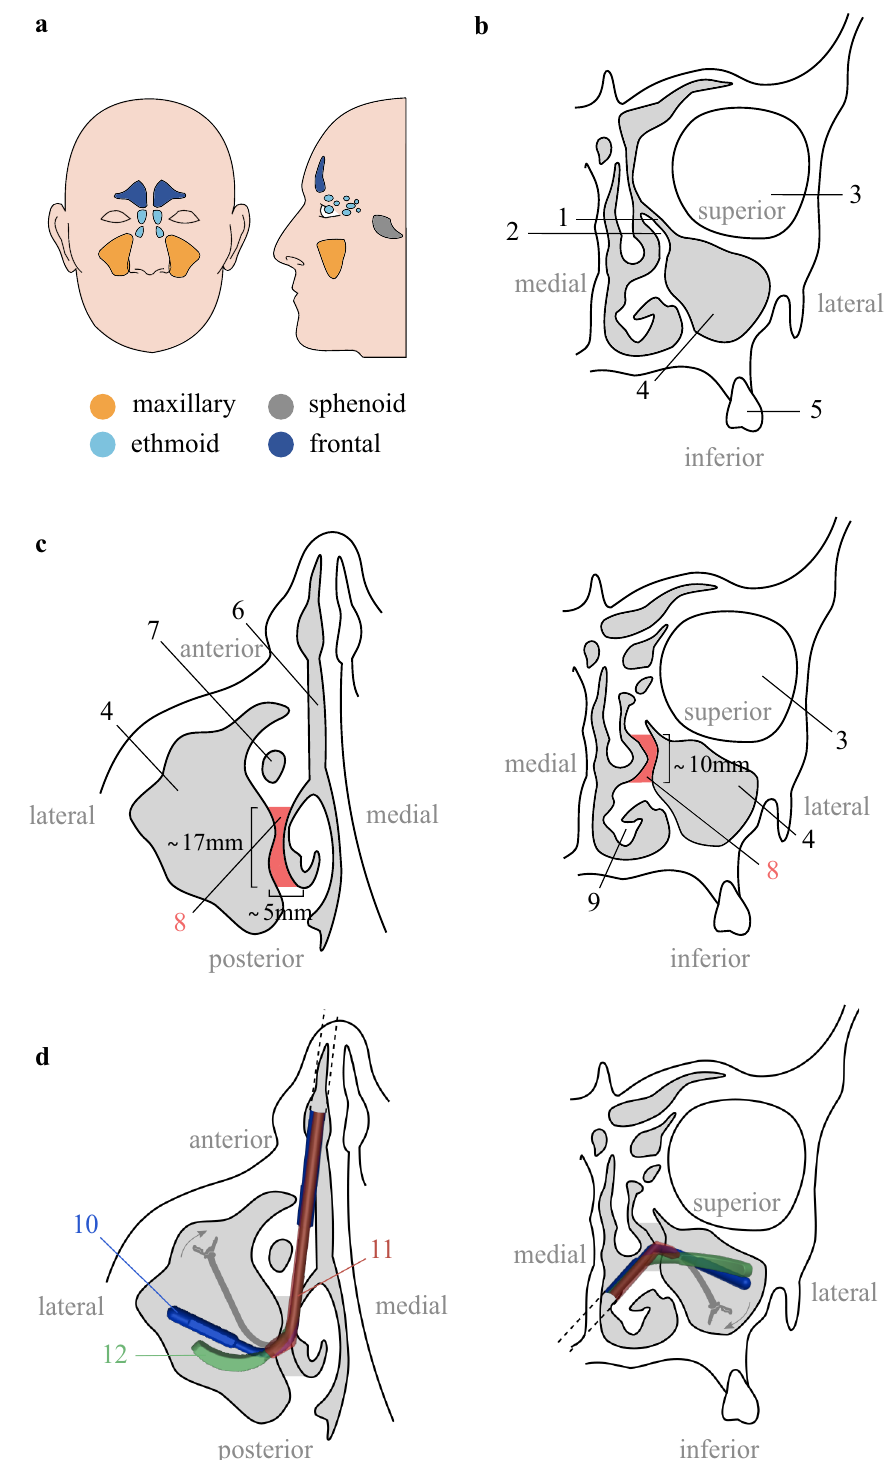
Figure 1. Maxillary sinus anatomy. ( a ),Location of the paranasal sinuses (Adapted from 2 ); ( b ) Maxillary sinus and nasal cavity anatomy in the coronal plane; ( c ) Maxillary sinus and nasal cavity anatomy with medial antrostomy dimensions and procedure in the axial (left) and coronal plane (right): resection of the tissues in red; ( d ) Insertion of some conventional instruments for sinus surgery into the maxillary sinus: transversal (left) ◦ and coronal (right) views: a 3.2 mm diameter forceps 45 upturned (11), a 2.5 mm diameter Heuwieser grasping ◦ forceps (12) and a 4 mm diameter double spoon forceps of 110 (10), and finally, insertion of an envisioned dexterous flexible instrument (gray). The gray surfaces represent cavities. The white areas are bony structures. 1. maxillary ostium; 2. uncinate process; 3. orbit; 4. maxillary sinus; 5. molar dentition; 6. nasal cavity; 7. lacrimal canal; 8. antrostomy; 9. inferior